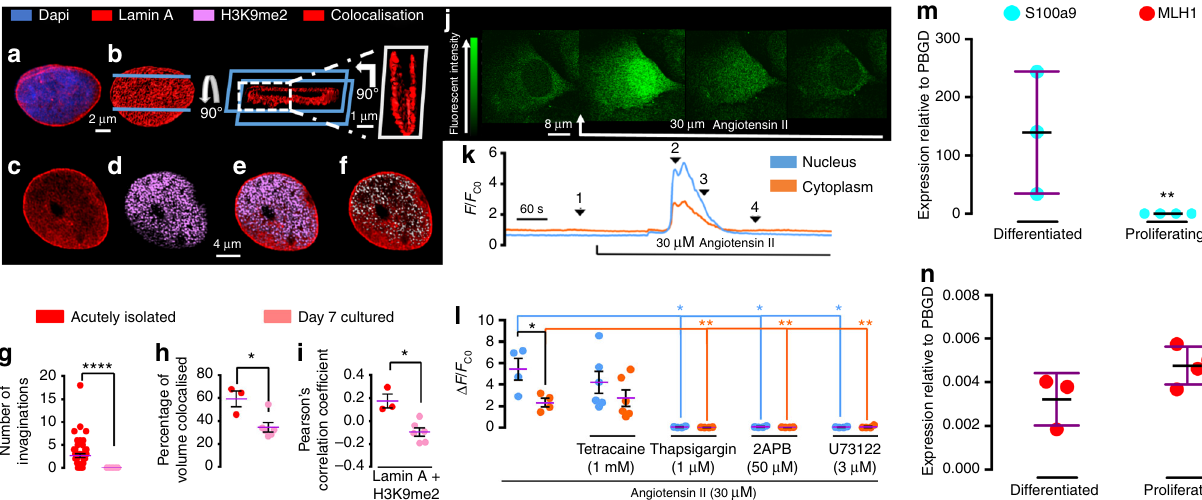
Fig. 7 Nuclear invaginations and nanocourses are dismantled during myocyte proliferation. a (left to right), 3D reconstruction of deconvolved confocal z stack through the nucleus (DAPI, blue) of a proliferating arterial myocyte labelled for lamin A (red). b Digital skin applied, a transverse then longitudinal section through and rotations of the nucleus. c Different proliferating myocyte. d As in ( c ) labelled for H3K9me2 (magenta). e ( c ) and ( d ) merged. f Merged image showing lamin A (red) labelling and H3K9me2 co-localisation (white). g Dot plot shows number of lamin A labelled nuclear invaginations per cell in acutely isolated arterial myocytes (red; n = 54 cells from 14 rats) and proliferating cells (pink; n = 9 cells from 5 rats). h Dot plot shows percentage volume of lamin A and H3K9me2 colocalization ( n = 3 acutely isolated cells from 3 rats; n = 6 cultured cells, from 3 rats). i Dot plot shows Pearson ’ s correlation coef fi cient colocalization ( n = 3 acutely isolated cells from 3 rats; n = 6 cultured cells, from 3 rats). j Deconvolved z sections of Fluo-4 fl uorescence in a proliferating myocyte (left to right) before and during application of (white arrow) 30 µ M Angiotensin II. k Records of Fluo-4 fl uorescence ( F x / F C0; F C0 = cytoplasm fl uorescence at time = 0, F x = fl uorescence at time = x) against time for the cytoplasm (orange) and nucleus (blue). l Dot plot for peak change ( Δ F x / F C0 ; mean ± SEM; n = 8 cells from 4 rats) induced by 30 µ M Angiotensin II in the absence and presence of: tetracaine (1 mM; 4 h pre-incubation; n = 5 cells from 3 rats); thapsigargin (1 µ M; 30 min pre-incubation; n = 4 cells from 3 rats), 2-Aminoethoxydiphenyl-borate (2APB, 50 µ M; 30 min pre-incubation; n = 4 cells from 3 rats) and U73122 (3 µ M; 30 min pre-incubation; n = 4 cells from 3 rats); one-way ANOVA with Dunnett ’ s multiple comparisons test: * p < 0.05, ** p < 0.01, *** p < 0.001, **** p < 0.0001. m , n Dot plots show (mean ± SEM) q-RT-PCR measures of S100A9 ( m ) and MLH1 ( n ) expression in proliferating myocytes; n = 3 rats (in triplicate); one-way ANOVA with Dunnett ’ s multiple comparisons test: ** p <